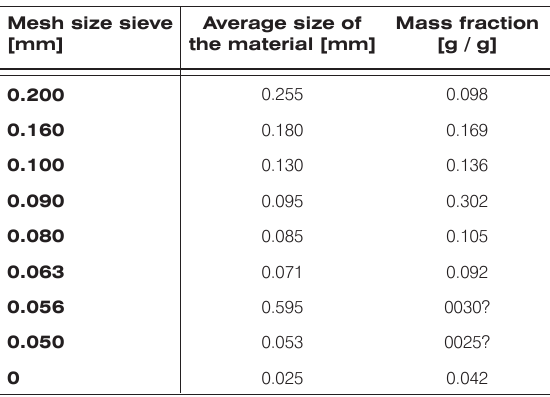
Table 2. The grain size distribution of CCP.